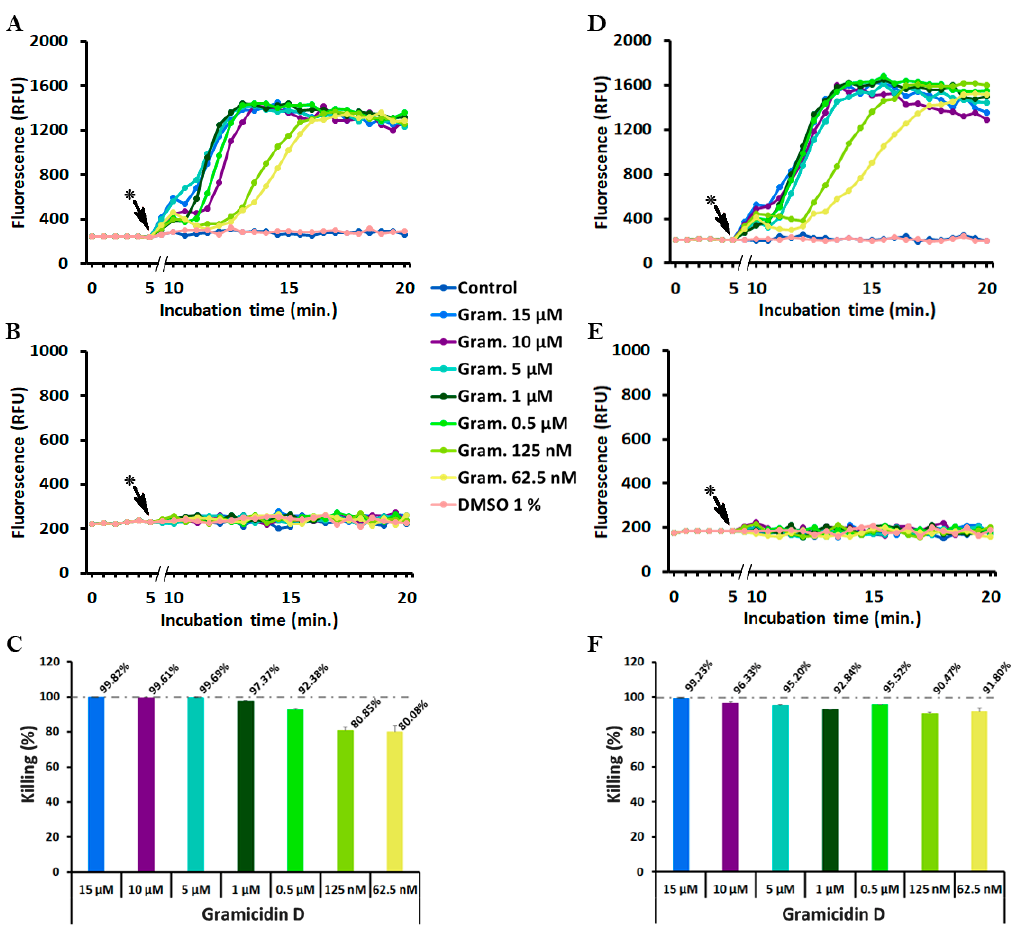
Figure 3. Membrane depolarization (diSC 3 (5)) ( A,D ), permeabilization (PI) ( B,E ) and killing ( C,F ) of S. epidermidis ( A–C ) and S. aureus ( D–F ) caused by gramicidin D. Experiments were performed with 10 8 CFU / mL of the indicated strains in PBS-glc with 400 nM diSC 3 (5) ( λ ex = 652 nm, λ em = 672 nm) and 5 µ g / mL PI ( λ ex = 535 nm, λ em = 617 nm) at 37 ◦ C. CFU counts were determined at 30 min incubation. For clarity purposes diSC 3 (5) and PI kinetics are in separate graphs, error bars were omitted and only the initial 20 (cid:48) are shown. (*) peptide